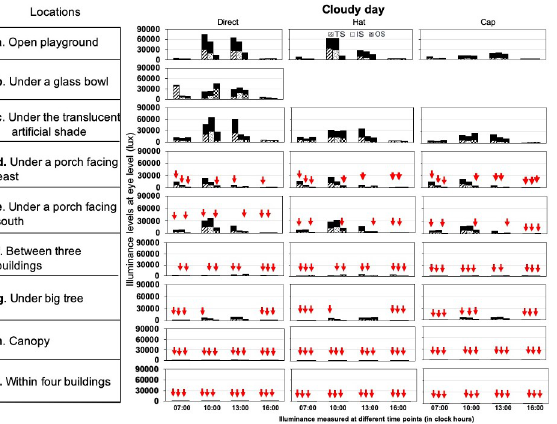
Fig 3. Illuminance levels recorded under direct source, hat and with a cap on two cloudy days. TS, IS and OS sensor source positions recorded in four different time points of a day (07:00–08:00, 10:00–11:00, 13:00–14:00 and 16:00–17:00 hours). The dark shaded area on the top of each bar represents the difference in illuminance levels obtained on two different sunny days. The downward-facing arrows in red colour represent illuminance levels < 1000 lux.